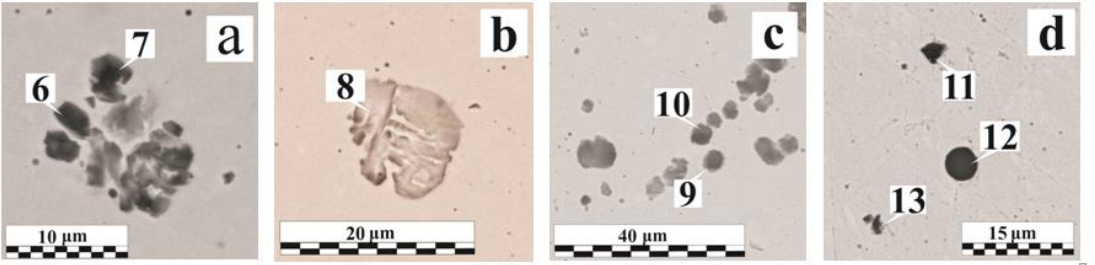
Figure 5. Nonmetallic inclusions in welds: ( a ) with OS-51-03 green, 95 μm; ( b , d ) with OS-51-03 green, 160 μm; ( c ) with OS-51-03 gray, 150 μm.